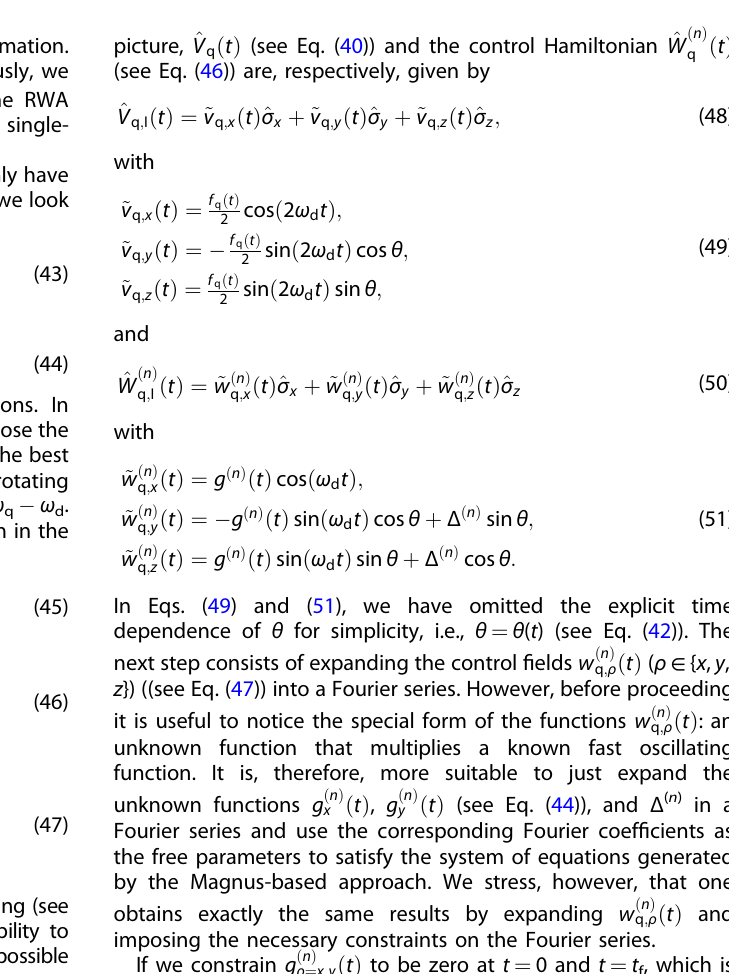
ð t Þ while in ( d ) we plot f ð n Þ ð t Þ ; see Eq. q ; x q ; y